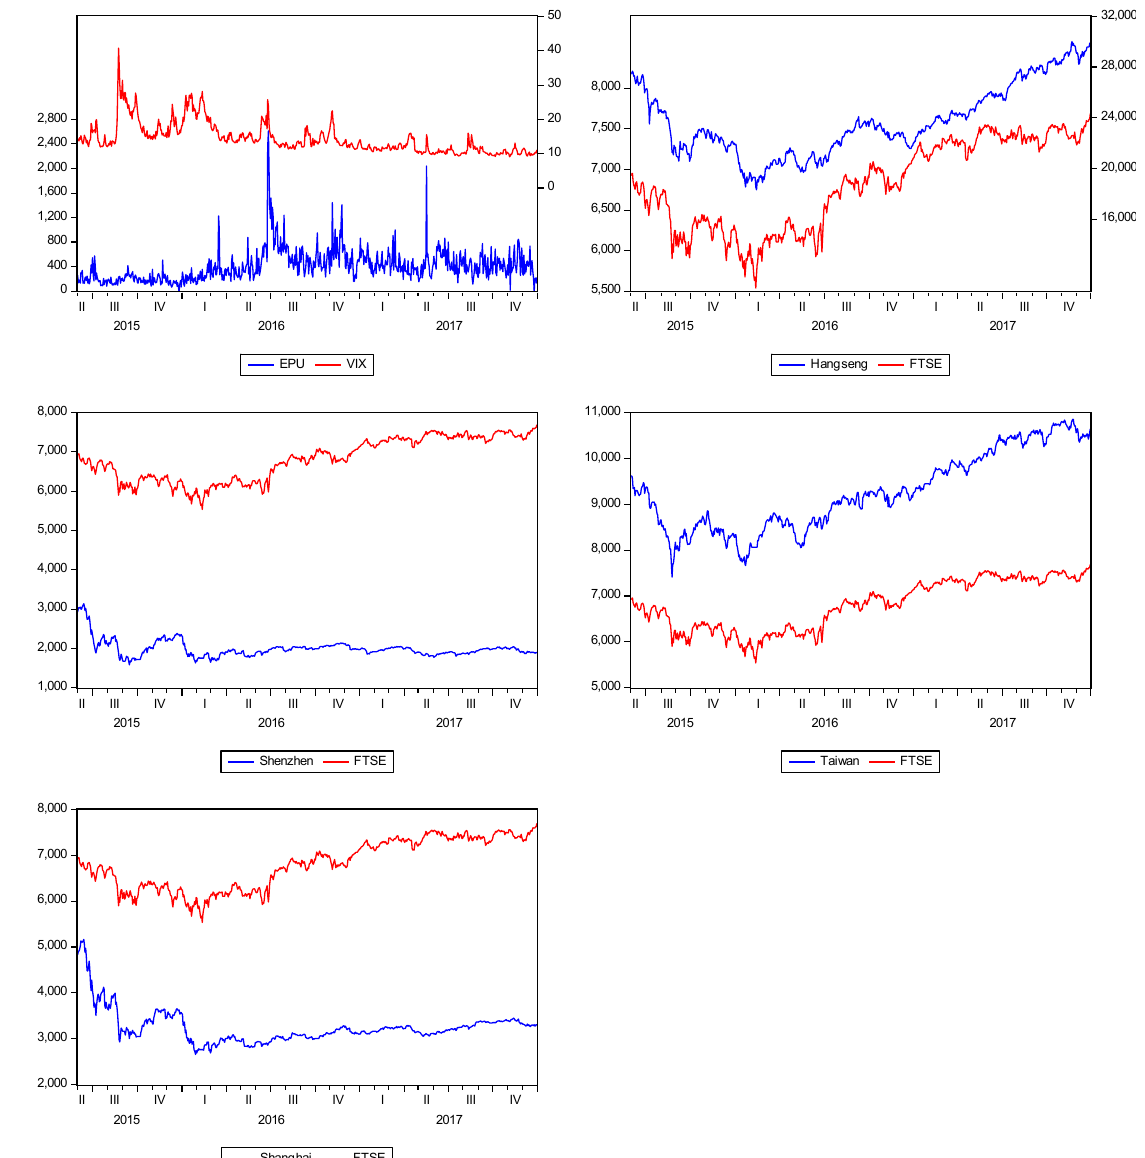
Figure A2. Pairwise Indices—Subsample Post Brexit.